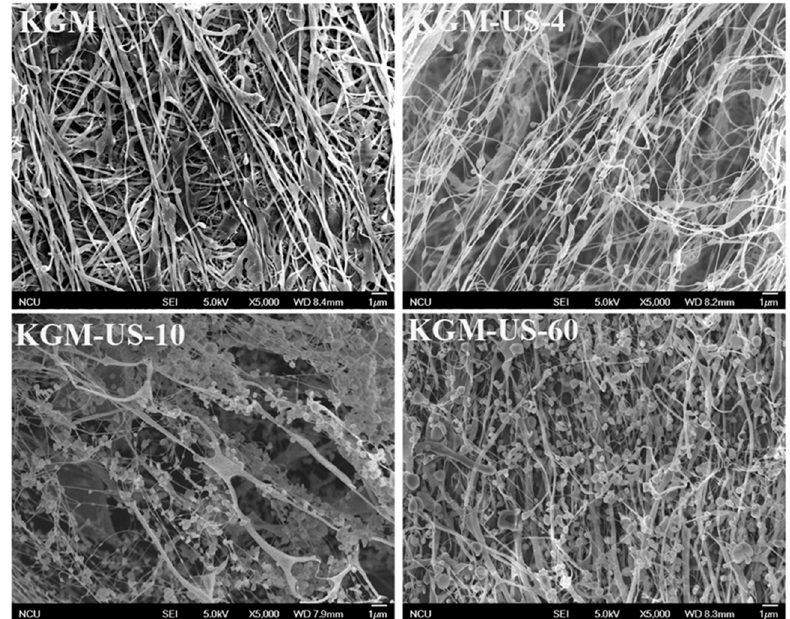
Figure 5. SEM images of original and US-treated KGM fractions (magnification 5000 × ).